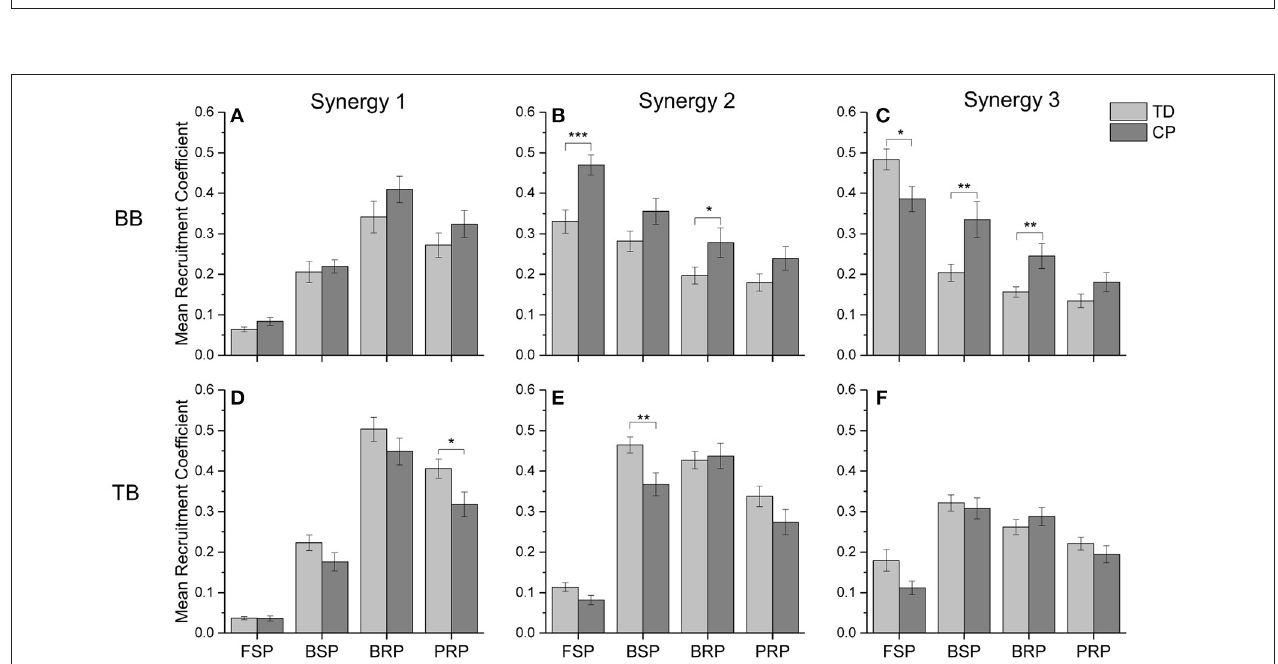
FIGURE 8 | The mean recruitment coefficient of three oscillation synergies from BB and TB in two groups. (A) synergy 1 of BB; (B) synergy 2 of BB; (C) synergy 3 of BB; (D) synergy 1 of TB; (E) synergy 2 of TB; (F) synergy 3 of TB. *0.01 < p < 0.05, **0.005 < p < 0.01, *** p < 0.005.